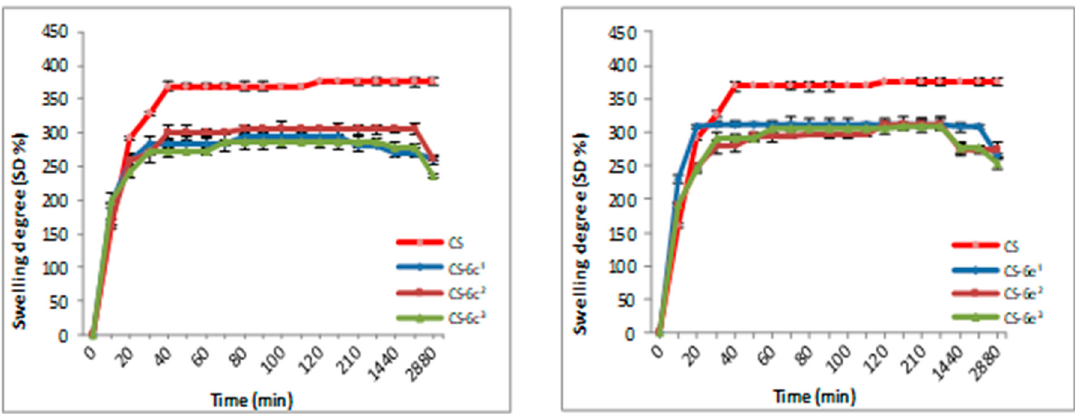
Figure 4. Swelling degree of CS and CS-XTDs (CS-6f; CS-6k) in distilled water at different concentrations ( 1 = 3 mg/mL, 2 = 4 mg/mL, 3 = 5 mg/mL).